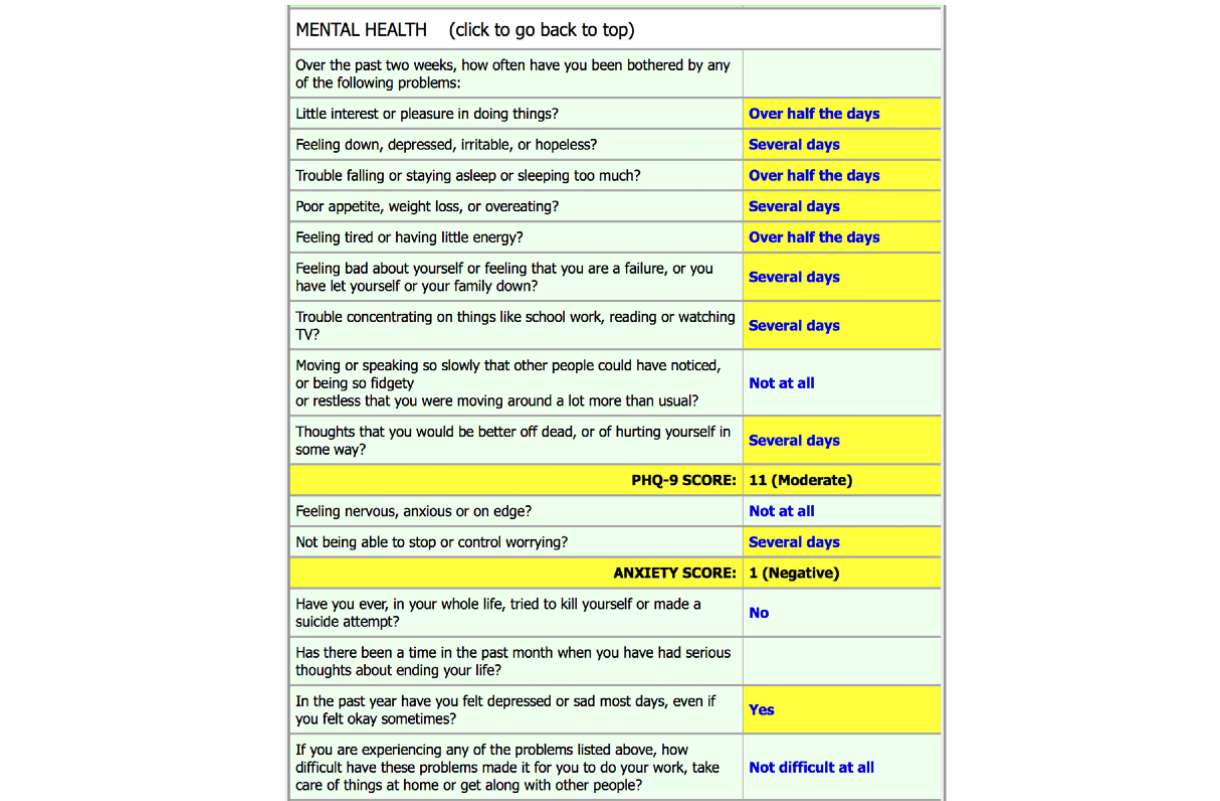
Figure 5. Patient-clinician collaborative review screen from